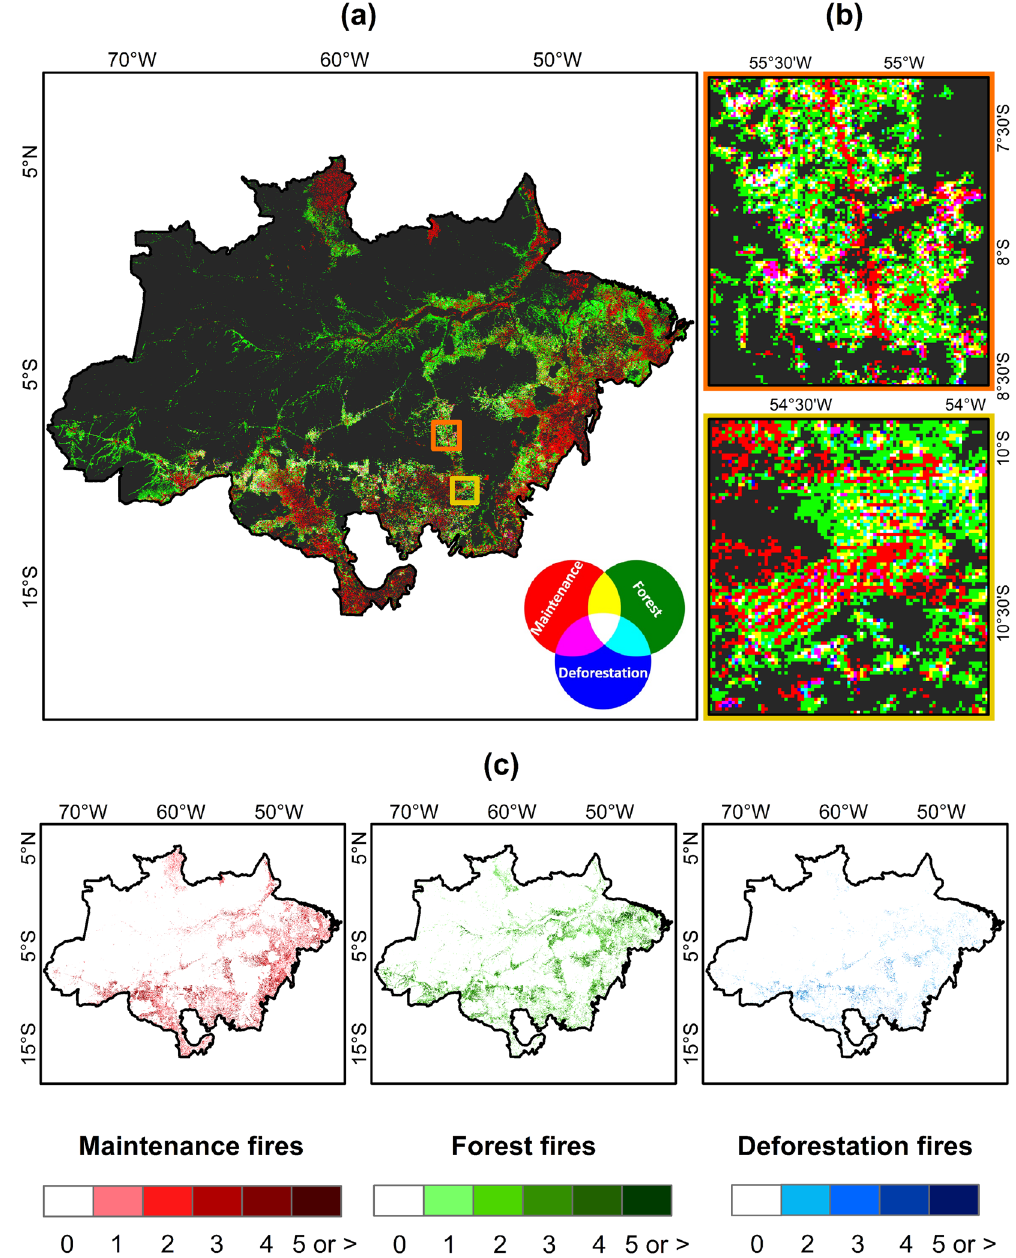
Figure 4. ( a ) RGB composite of fire types for the period 2003–2019 at 1 km resolution; ( b ) insets showing spatial detail of fishbone deforestation and subsequent use for an area in Northern Mato Grosso (yellow rectangle) and Southwestern Pará (orange rectangle); ( c ) cumulative fire counts of maintenance, forest, and deforestation fires over the period 2003–2019. Colour scales show the number of active fire detections in each 1 km pixel. In panels ( a ) and ( b ) we have used Python and QGis open-source